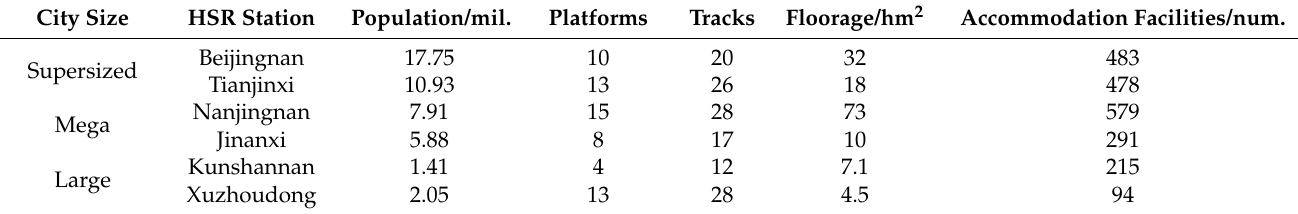
Table 1. Basic information about the research